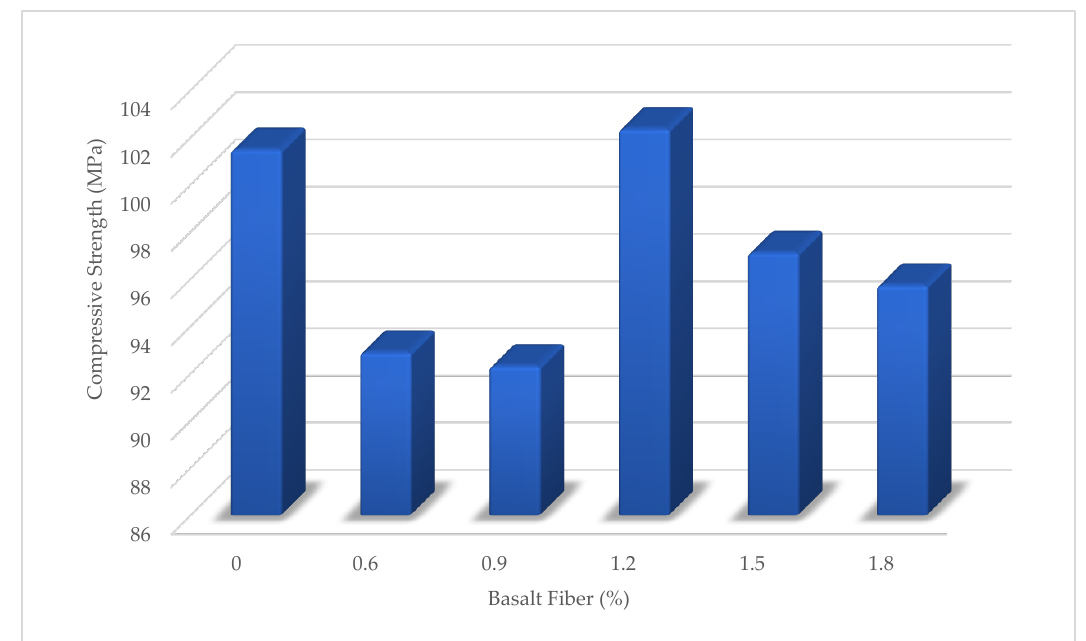
Figure 11. Compressive Strength of BFHPC, With Different BF Percentages.